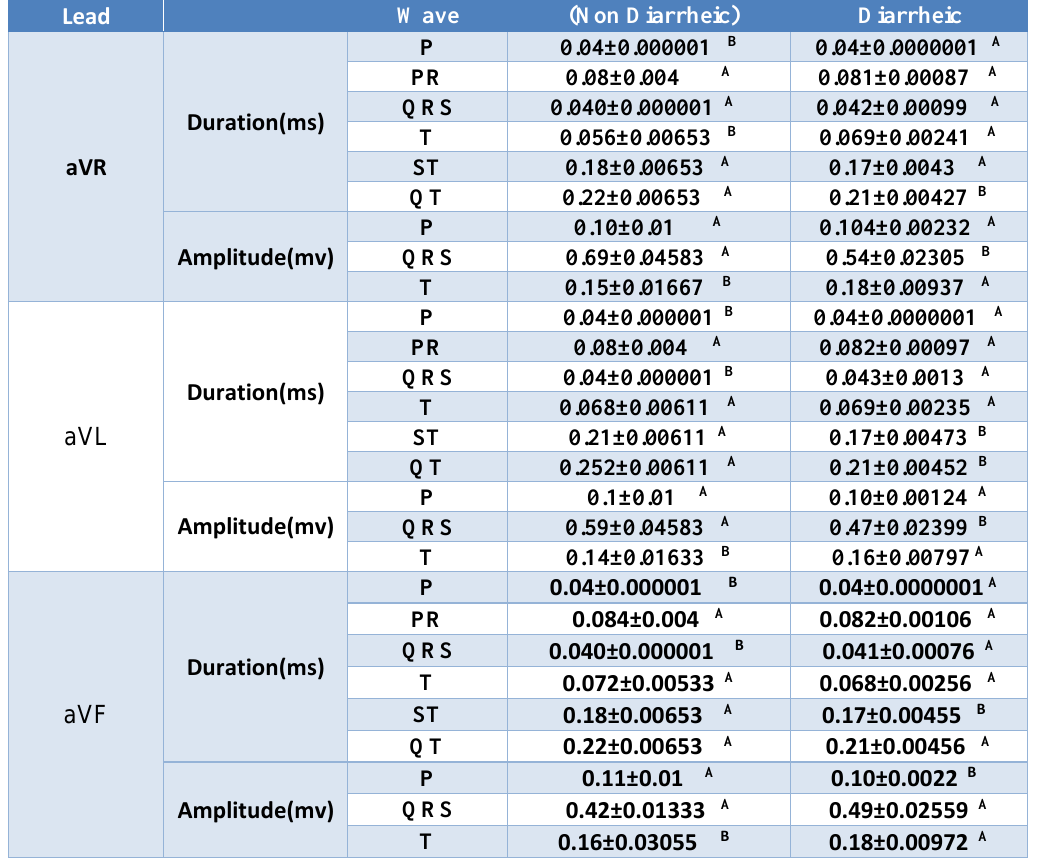
Table (3) showed abnormal morphology of electrocardiographic wave’s diarrheic lamb.